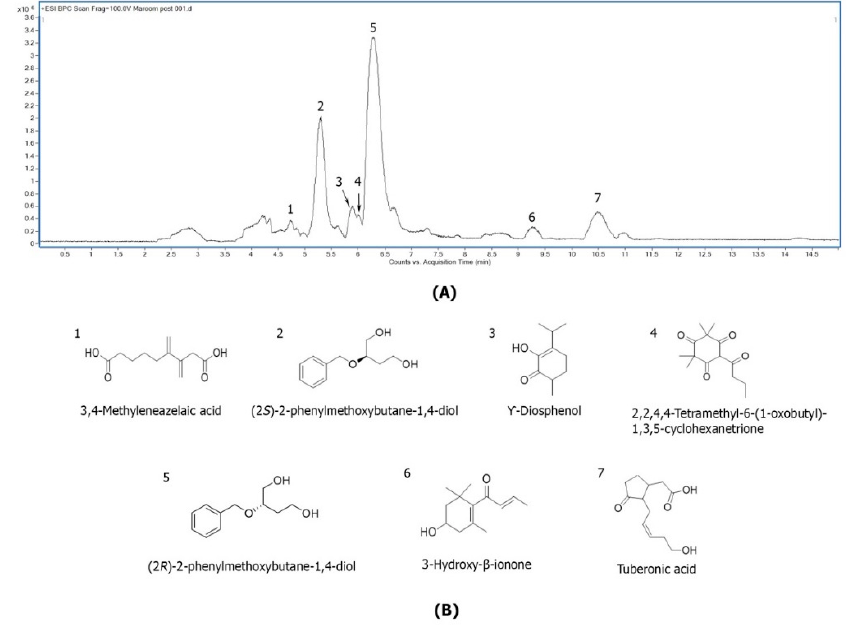
Figure 1. Base peak chromatogram of MO subfraction at concentration 20 mg / mL in at line system. ( A ) LC-MS base peak chromatogram (BPC) of subfraction 6.17.2 with active compounds no. 1 – 7 and ( B ) the tentative structure.